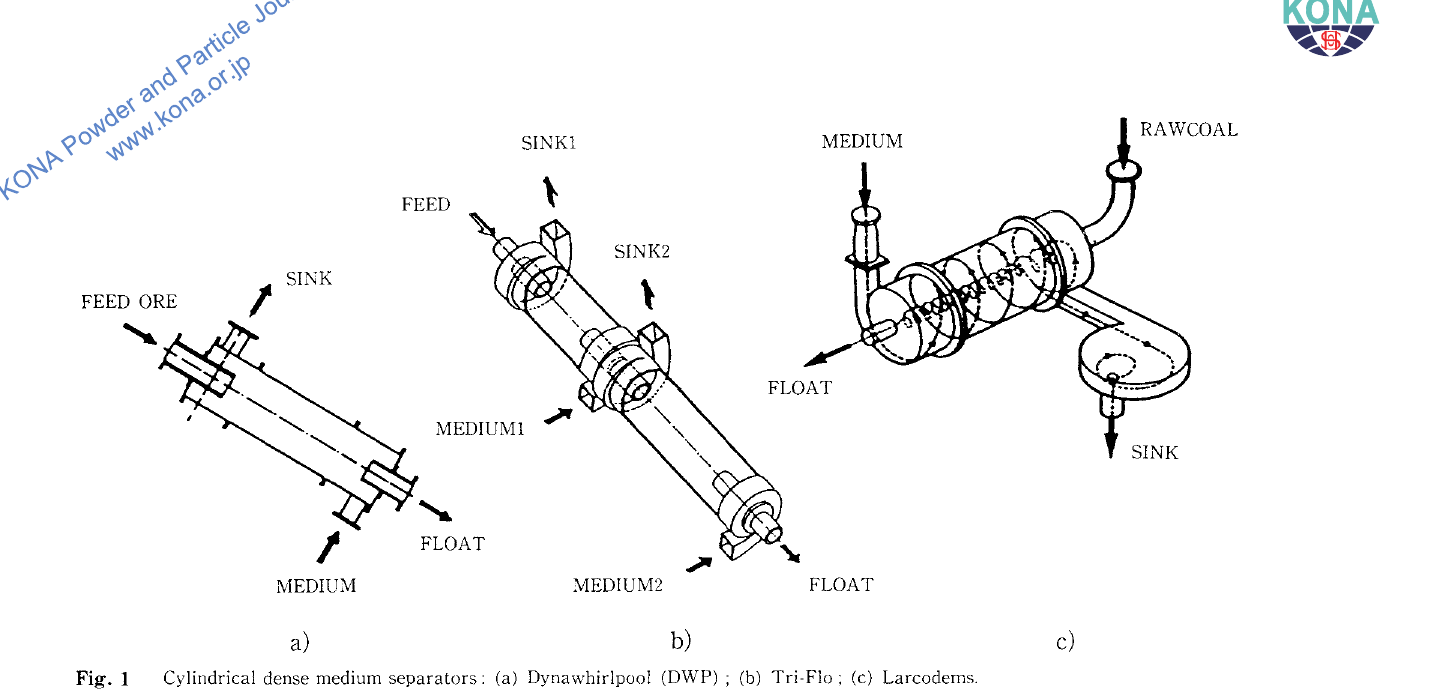
Fig. 1 Cylindrical dense medium separators: (a) Dynawhirlpool (DWP) ; (b) Tri-Flo; (c) Larcodems. tangentially exits the bottom of the cylinder. The